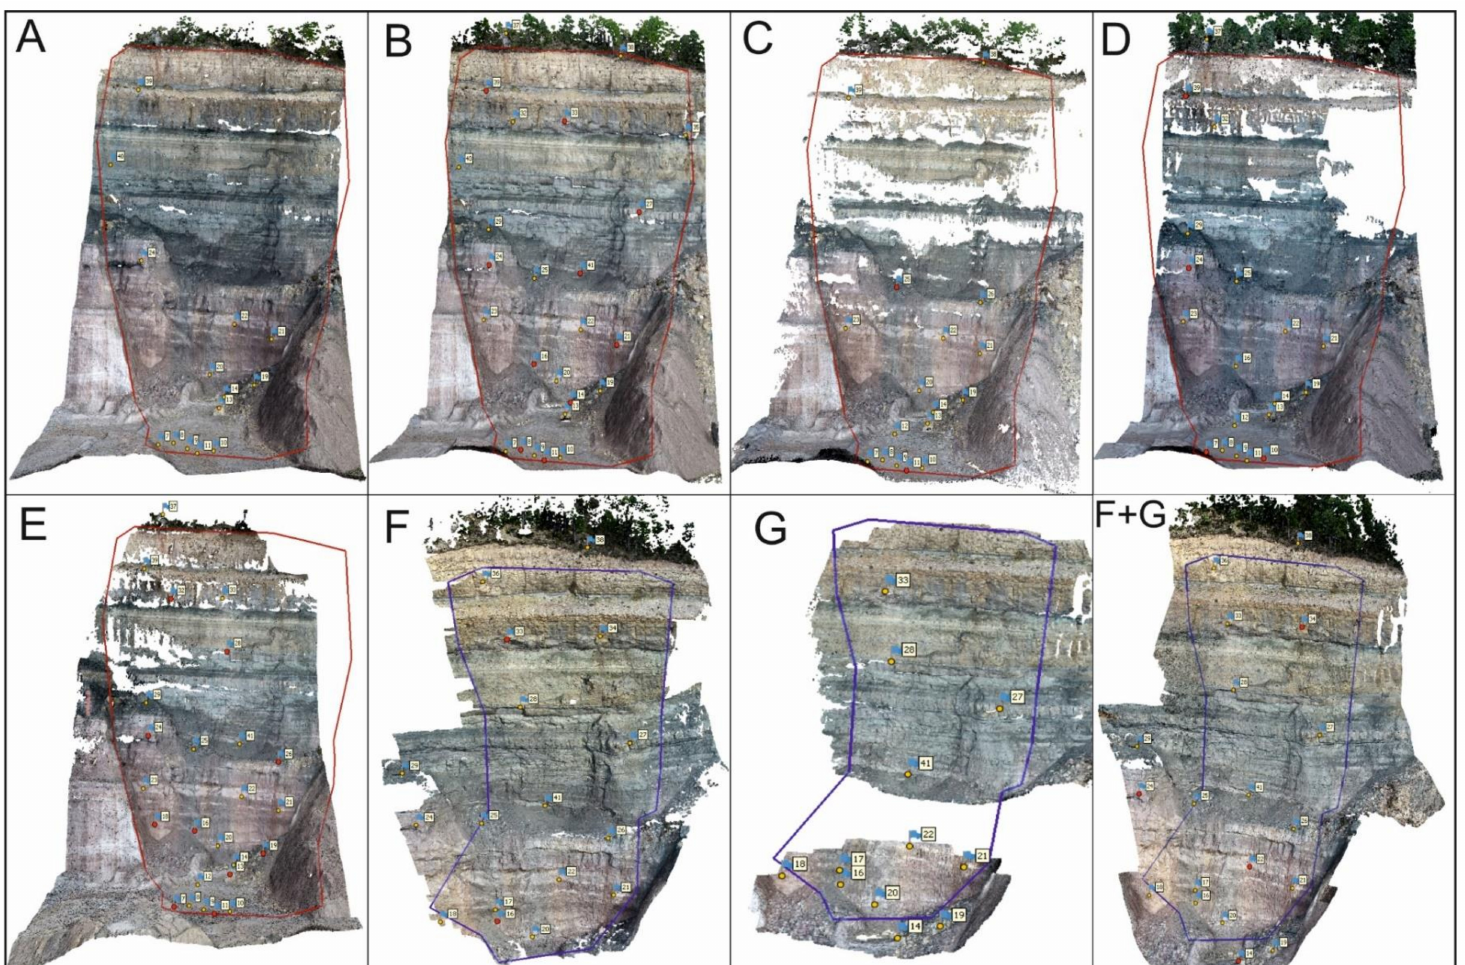
Figure 4. Dense point clouds showing the distribution of control (yellow) and check (red) points of the different SfM-UAV surveys. ( A ) AMSL-nadir; ( B ) AMSL-40 ◦ off-nadir; ( C ) AGL-nadir; ( D ) AGL-40 ◦ off-nadir, ( E ) AGL-Point of Interest; ( F ) facade-nadir; ( G ) facade-40 ◦